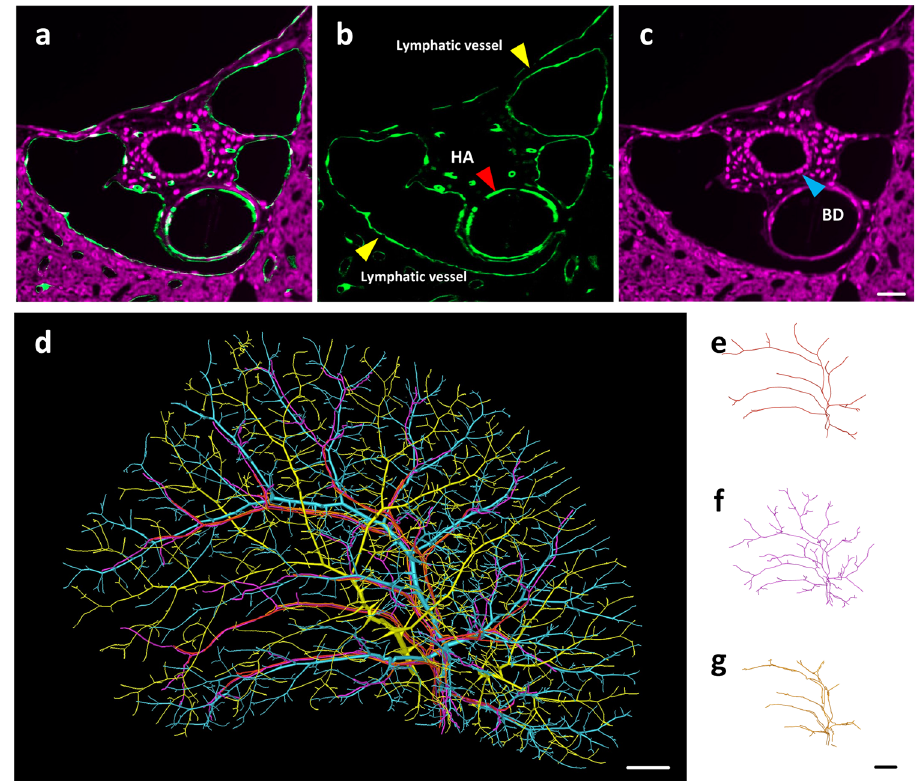
Fig. 3 The reconstruction of the hepatic artery, bile duct, and lymphatic vessel. a Portal triads in merged channel images. b Portal triads in vessel channel images. The red arrow indicates the hepatic artery. The yellow arrows indicate the lymphatic vessels. c Portal triads in cytoarchitecture channel images. The blue arrow indicates the bile ducts. d The combination of the reconstructed blood vessels, bile ducts, and lymphatic vessels in the liver. Portal vein is marked with cyan. Hepatic vein is marked with yellow. Bile ducts is marked with purple. Hepatic artery is marked with red. Intrahepatic lymphatic vessel is marked with orange. e – g Structure of hepatic artery, intrahepatic bile ducts, and intrahepatic lymphatic vessel are shown separately. HA hepatic artery, BD bile duct. Scale bar, a – c 20 µ m, d – g 1 mm.